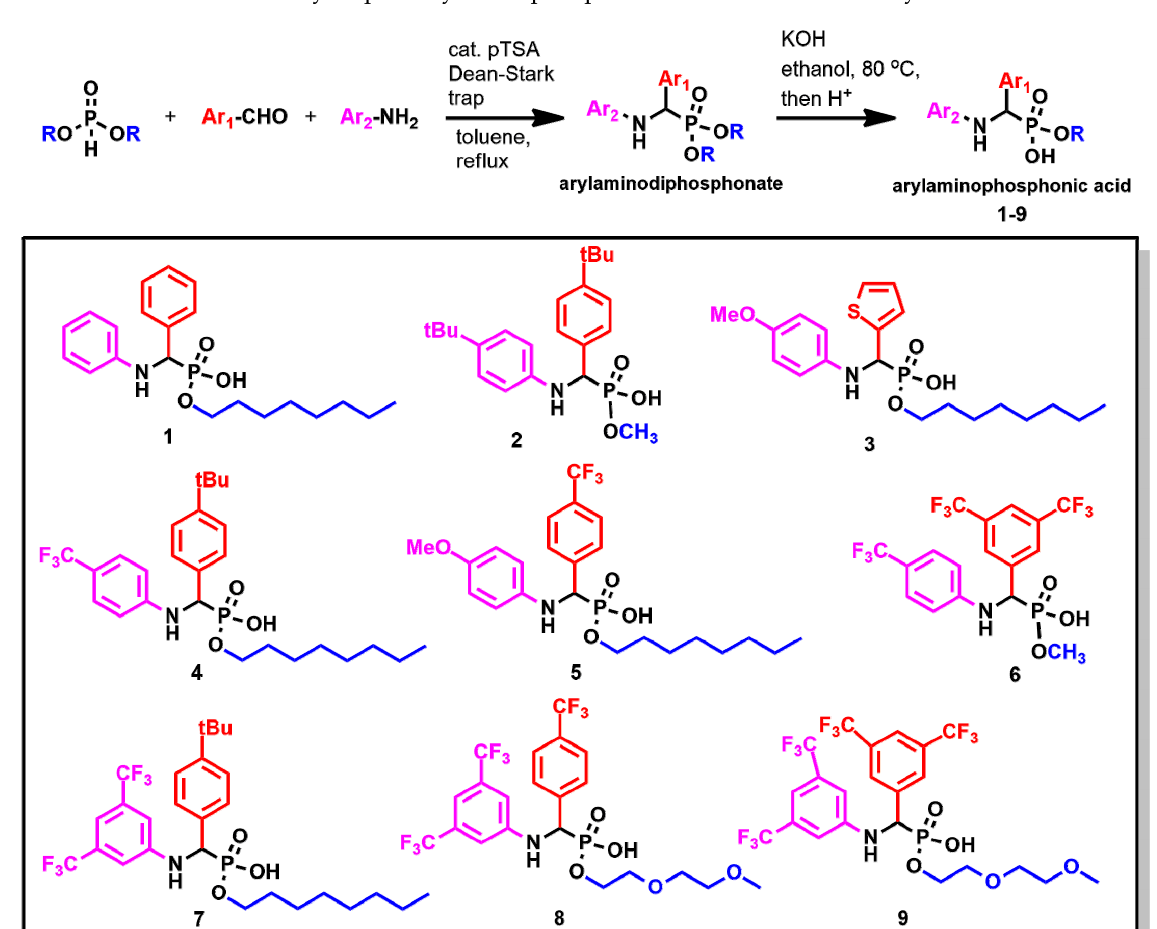
Figure 2. The synthesis of arylamino phosphonic acids 1 – 9 .